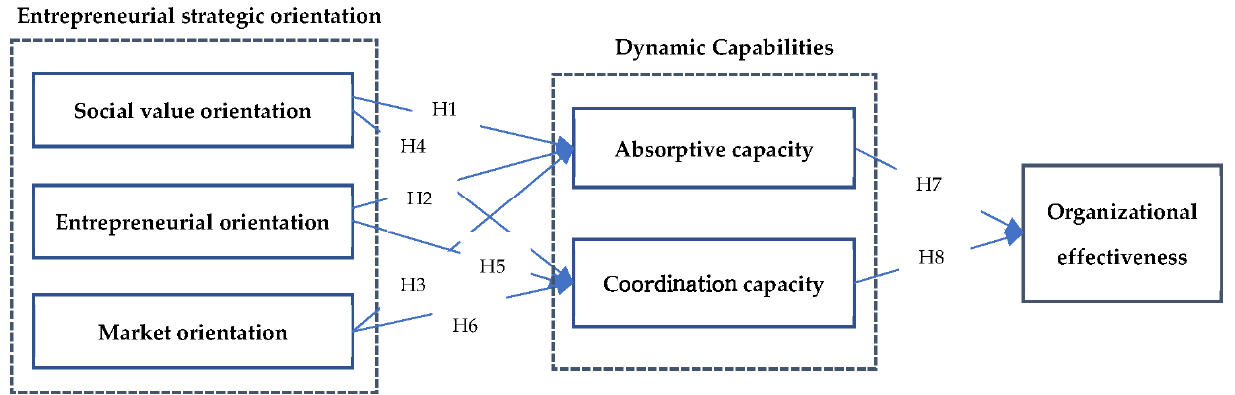
Figure 1. Research